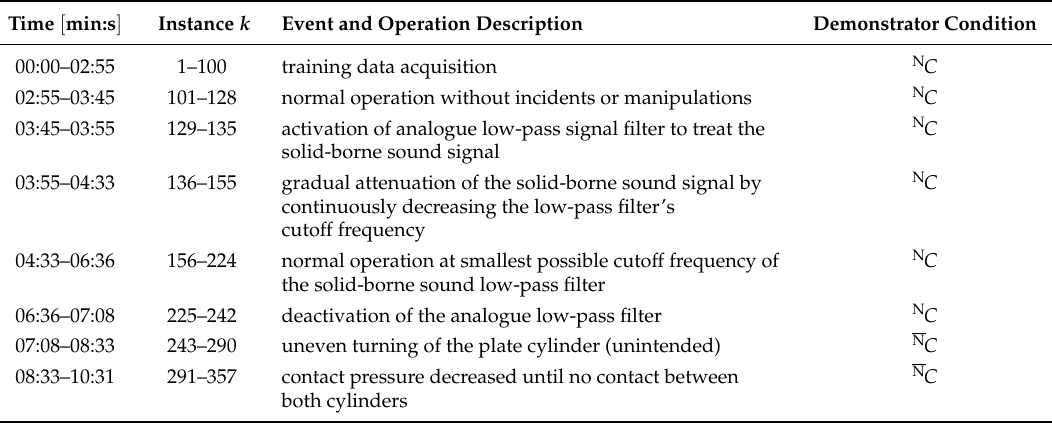
Table A3. Description of the printing unit demonstrator operation and the events, which occurred during the manipulated printing unit demonstrator operation experiment. These are covered by the PU manip data set. The demonstrator condition reflects the objective assessment of the printing unit demonstrator by the human experimenter during operation.